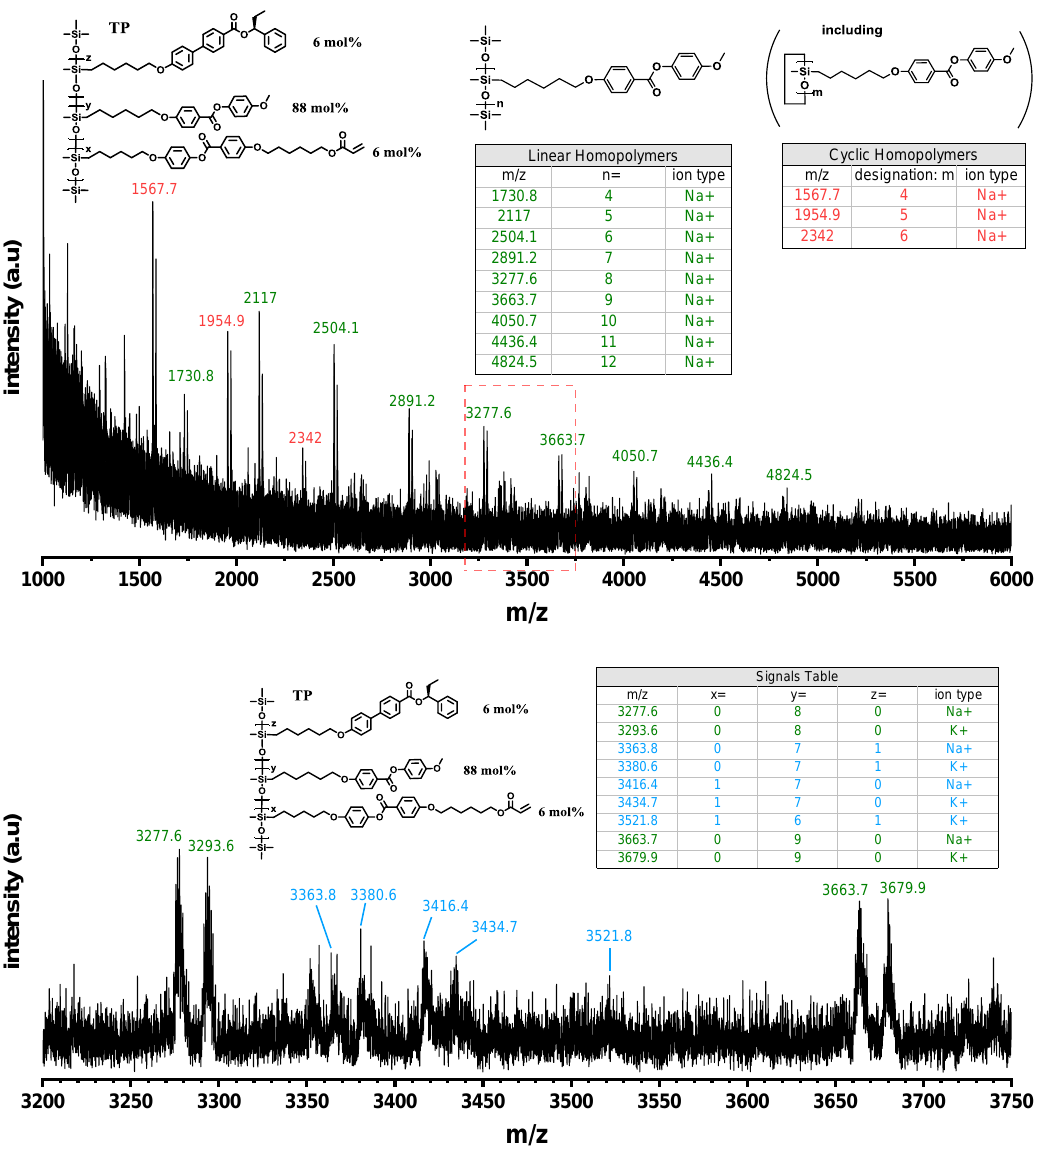
Figure2. Matrix-assistedlaserdesorption / ionization-timeofflightmassspectrometry(MALDI-TOF-MS) Figure 2. Matrix-assisted laser desorption/ionization-time of flight mass spectrometry (MALDI-TOF- spectrum (top) and zoom in (bottom) of TP, with captions indicating di ff erent MS) spectrum (top) and zoom in (bottom) of TP, with captions indicating different species.